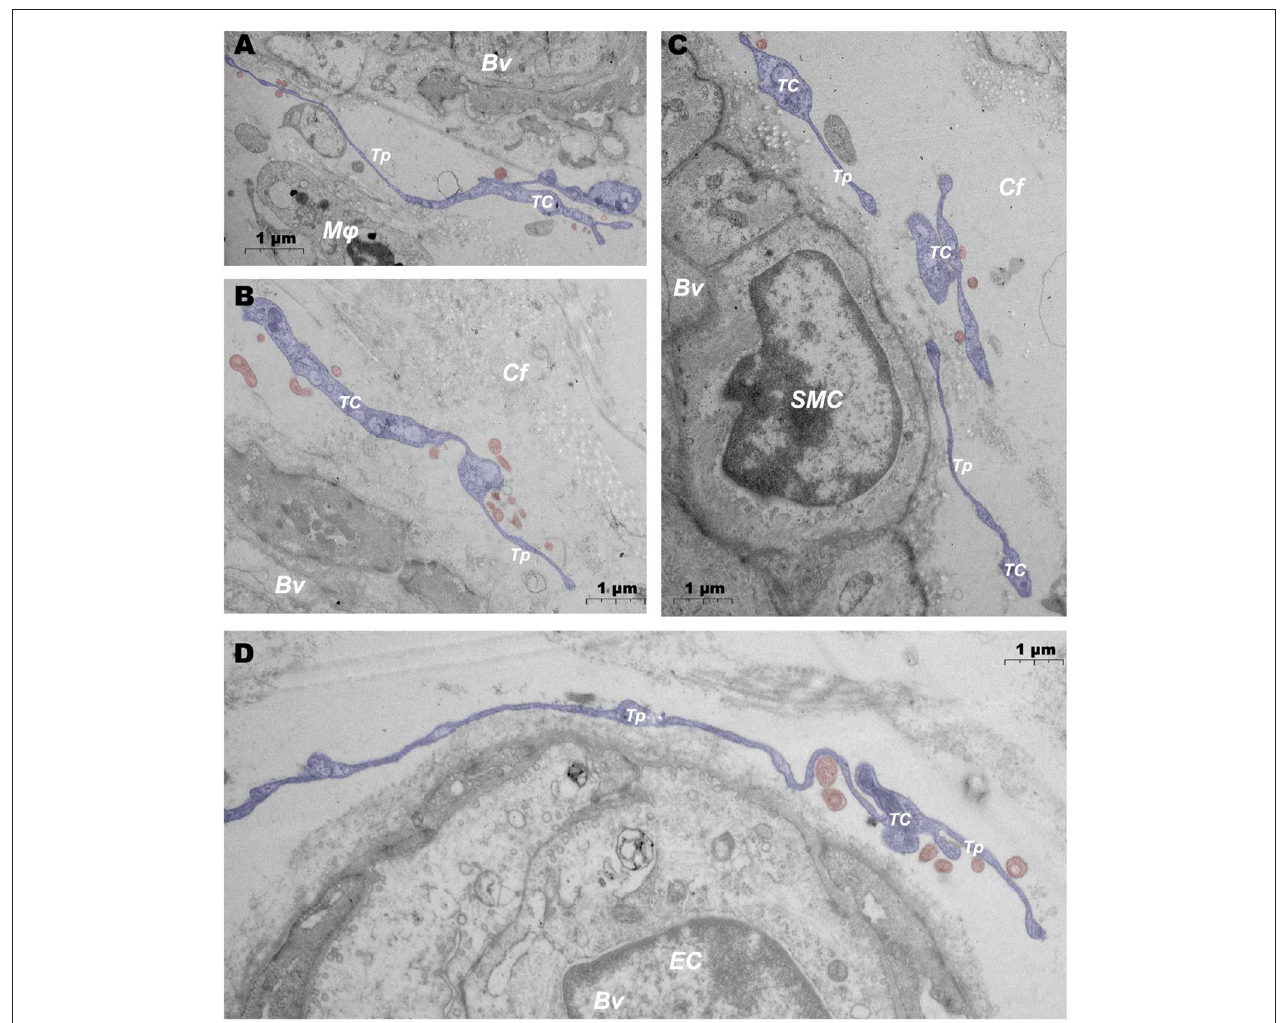
FIGURE 8 | Ultrastructural analysis of TCs after jet needle-free injection via TEM. (A–D) After jet needle-free injection, TCs at different locations in the DMUs releases a large number of vesicles. BV, blood vessels; M φ , macrophage; TC, telocyte; Tp, telopode; Cf, collagen fiber; SMC, smooth muscle cell; EC, endothelial cell; Blue mark, telocytes; Red mark, vesicles. Scale bar (A–D) = 1 µ